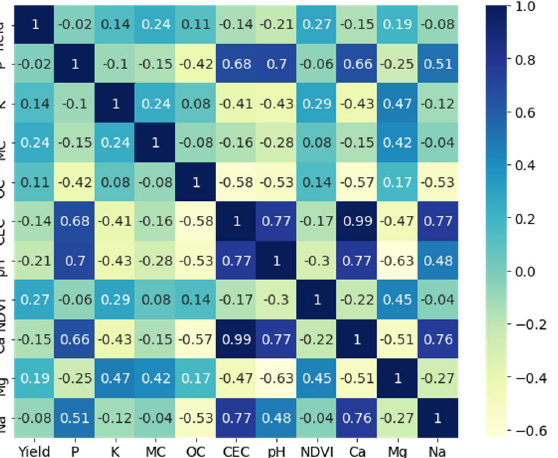
Figure 7. The cross-correlation (Pearson correlation) matrix of the soil attributes in field